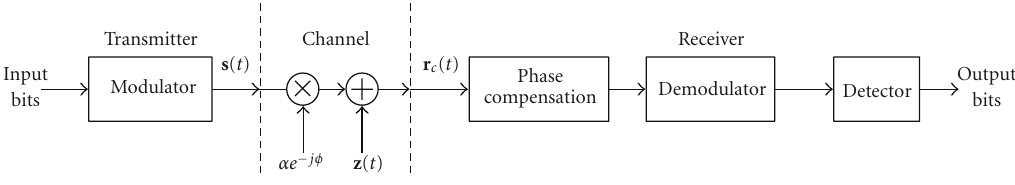
Figure 1: The system